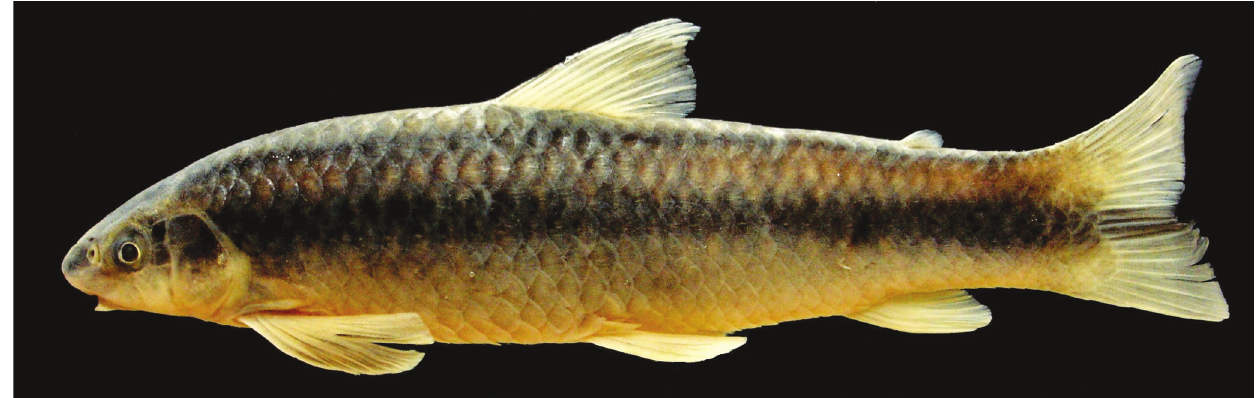
Fig. 8. Parodon magdalenensis , Holotype, ICN 17099, 108.6 mm SL, Colombia, Caldas, Norcasia, La Miel River at escape tunnel, middle Magdalena River